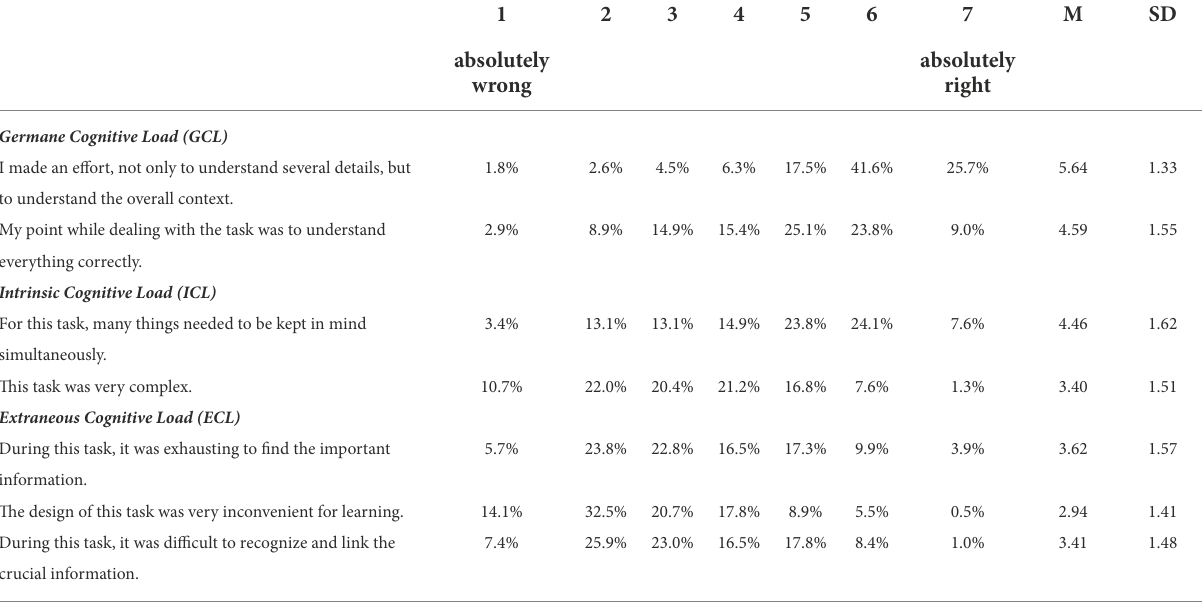
TABLE 5 User experience of cognitive load as challenge